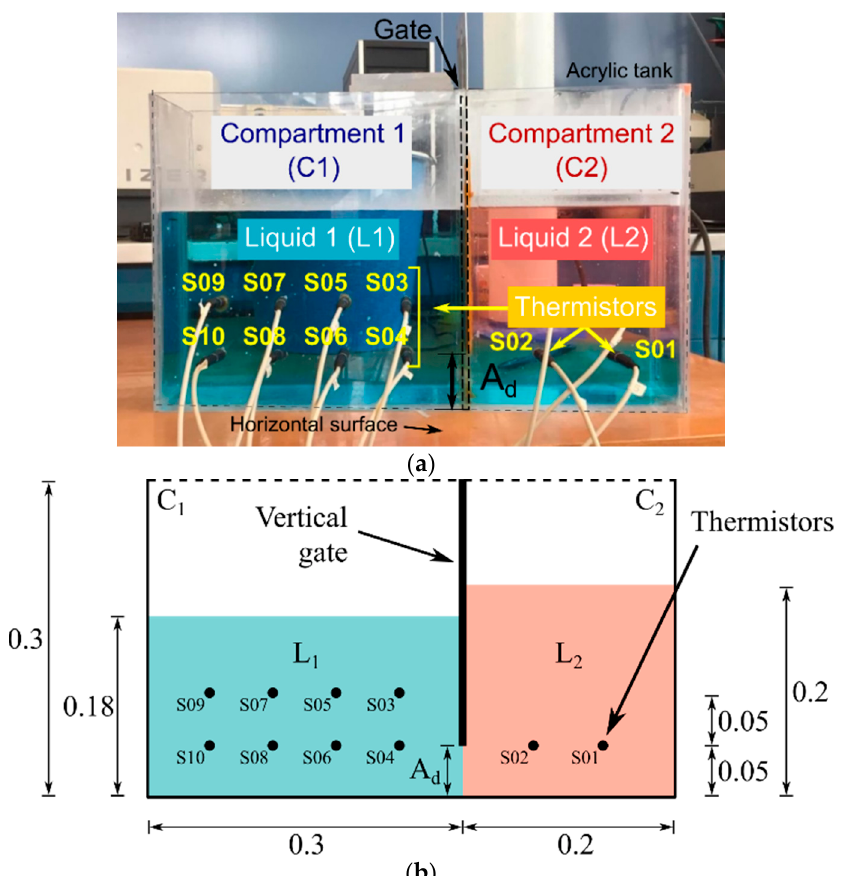
Figure 2. ( a ) Experimental installation and ( b ) scheme of the experimental setup.